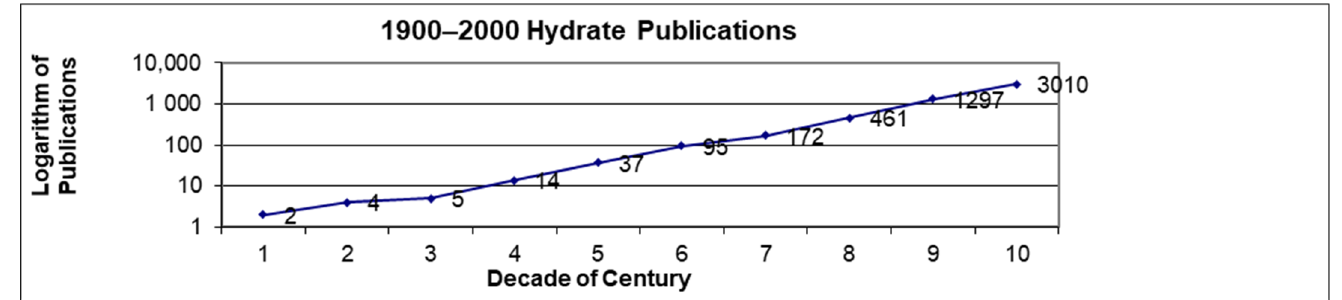
Figure 1. Base 10, semi-logarithmic plot of the number of hydrate publications by decade, from 1900–2000. Note the increases in slopes about 1934 and 1965, the years of hydrate discovery inside and outside of flowlines, respectively.